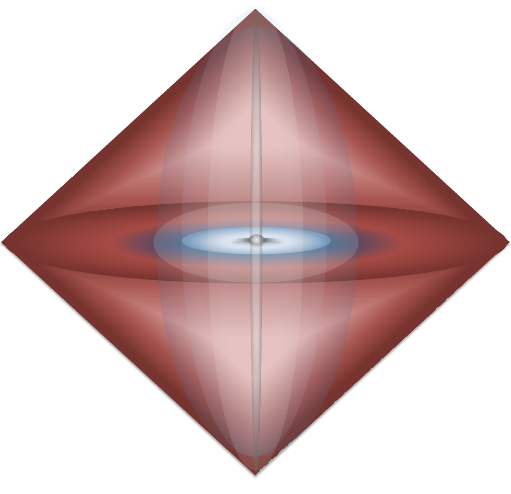
Figure 4: The one-sided perspective on de Sitter space with a mass M in the center. The entropy associated with the horizon area is contained in delocalized states that occupy the bulk. The mass M removes part of, and therefore displaces, the entropy content in the